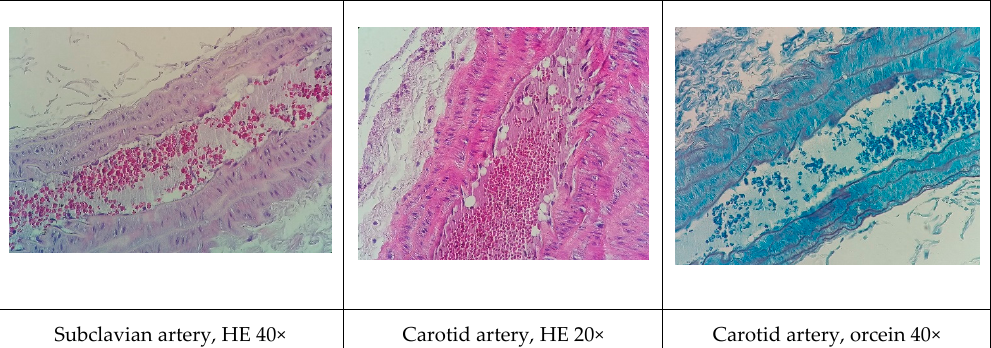
Figure 3. Representative cross-sections of the liver, left ventricle, kidney, and subclavian and carotid arteries in the LEAD group. HE, hematoxylin-eosin staining; LEAD, normotensive and non-ovariectomized rats that received the atherogenic diet, methimazole, cholecalciferol, and L -NAME.